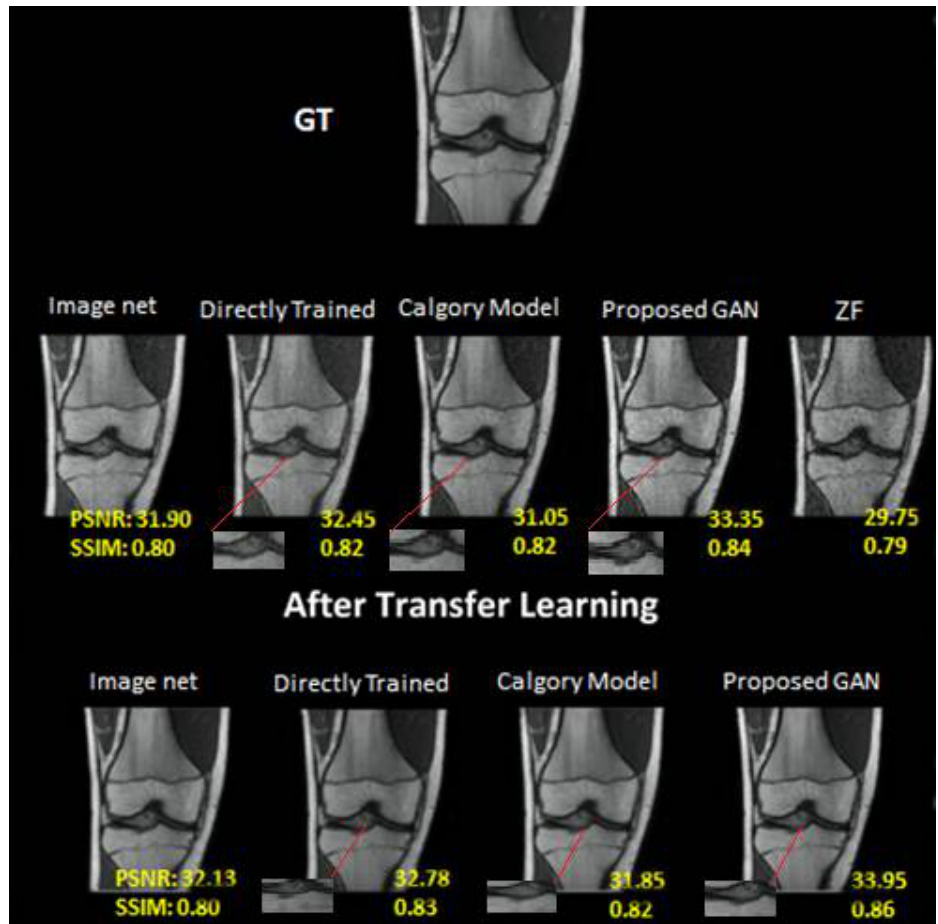
Figure 10. At AF = 4, Reconstruction results on knee dataset. Moving left to right: (i) Image Net; (ii) Directly trained; (iii) Calgary Model; (iv) Proposed GAN; (v) ZF. In the second row: (i) Image net; (ii) Directly Trained; (iii) Calgary Model; (iv) Proposed GAN results of same slices from knee image dataset after applying transfer learning.